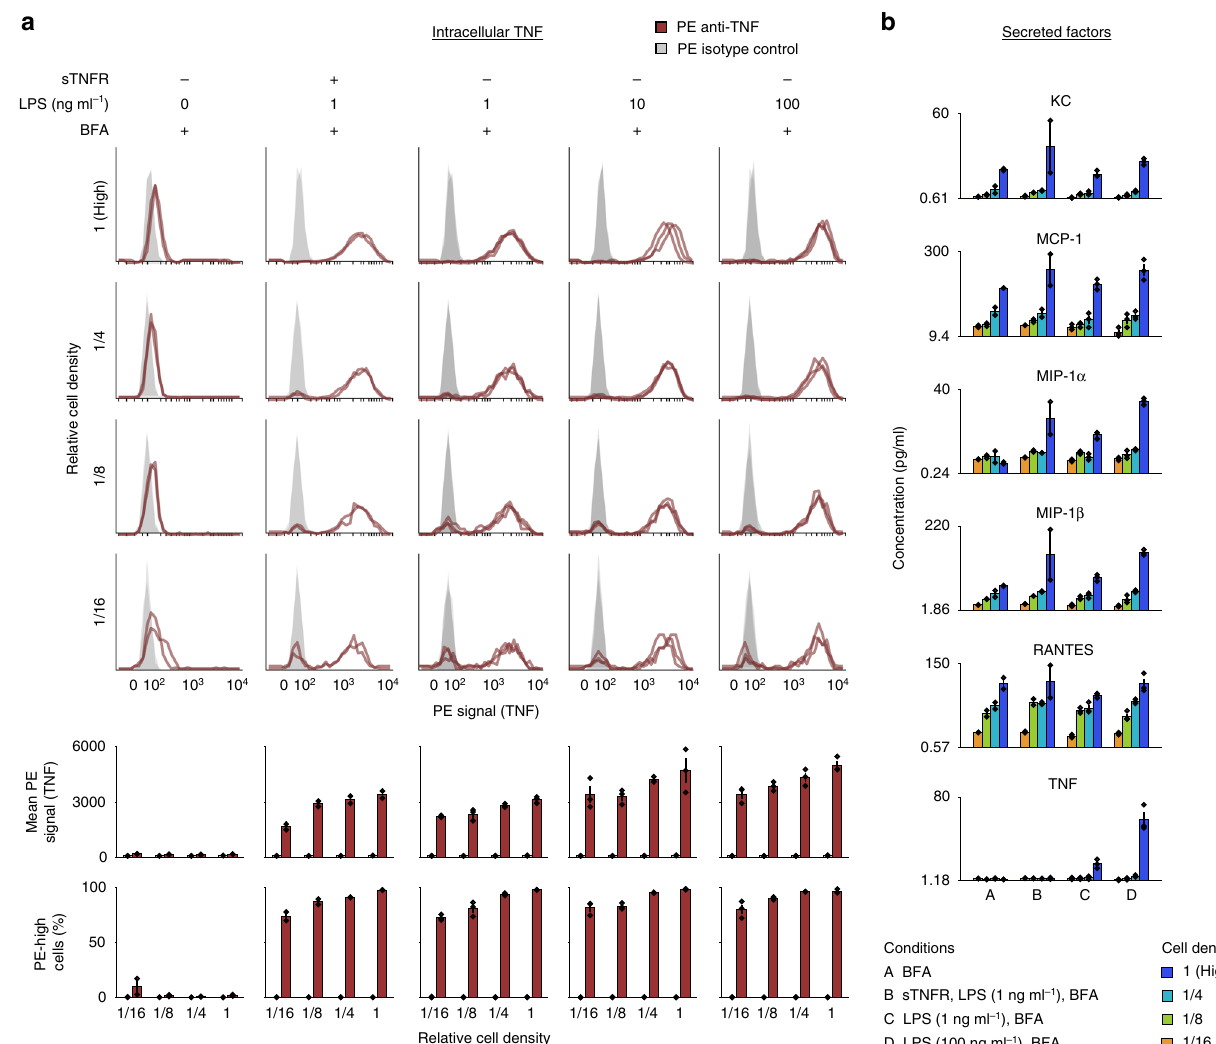
Fig. 5 Primary macrophages regulate TNF production through quorum licensing. a Bone marrow-derived macrophages exhibit cell density-dependent bimodality in LPS-induced TNF expression. The fi rst two conditions (columns) are in biological duplicate and the other three conditions are in biological triplicate. b Secreted factors were measured in cell culture supernatants. The minimum value on each y -axis is the observed lower limit of detection of the assay. A subset of the panel is included here, and the full panel is in Supplementary Fig. 5d – f. Bar graphs represent the mean of the biological replicates and S.E.M. Effects of cell density and treatment condition were assessed using two-factor ANOVAs and Tukey ’ s HSD tests (Supplementary Note 2). Source data are provided as a Source Data fi